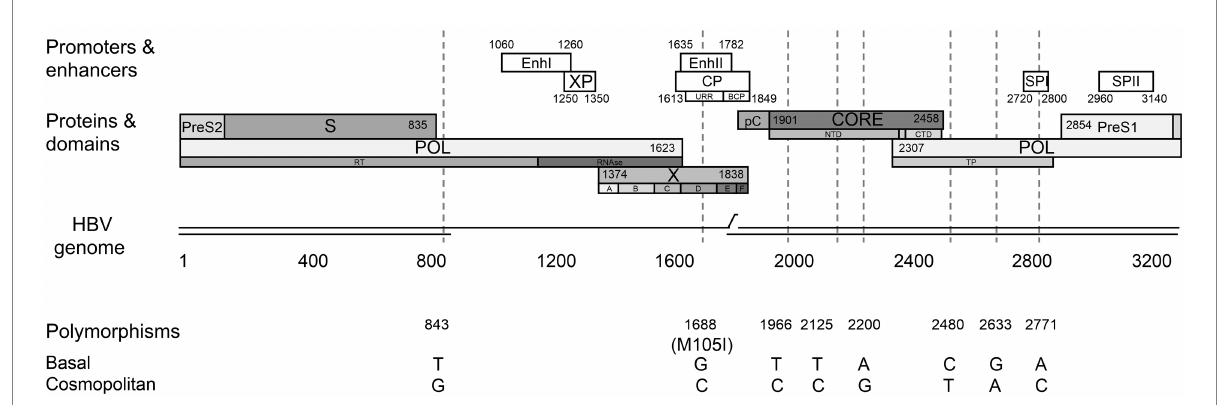
FIGURE 2 Differential nucleotide signature pattern between subgenotype F1b clusters. Schematic representation of HBV genome including enhancers I and II, promoters (white boxes) and proteins (gray boxes). Polymorphisms in nucleotide positions: 843, 1688, 1966, 2125, 2200, 2480, 2633, 2771 are